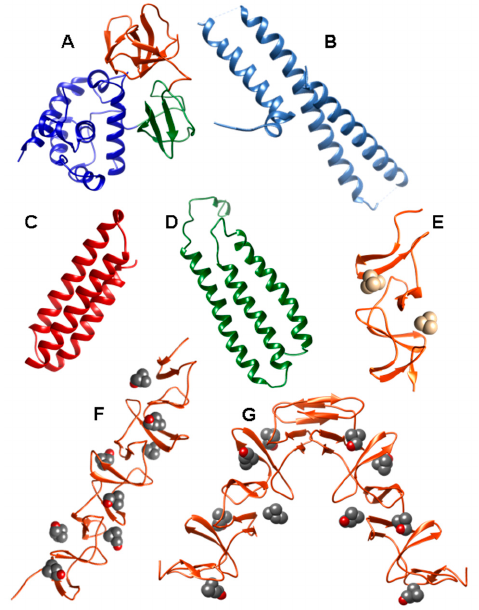
Figure 7. Three-dimensional structures of isolated domains from CBPs. ( a ) Functional module of LytB N -acetylglucosaminidase (PDB code: 4Q2W) (LytB CAT ) depicting the SH3b, WW and GH73 domains in orange, green and blue respectively; ( b ) Lactoferrin-binding domain of PspA (PDB code: 2PMS); ( c ) CbpAN domain of PspC (PDB code: 2M6U); ( d ) R2 domain of PspC (PDB code: 1W9R); ( e ) Choline-binding module of CbpM (PDB code: 3HIA) containing N , N , N , N -tetramethylammonium in